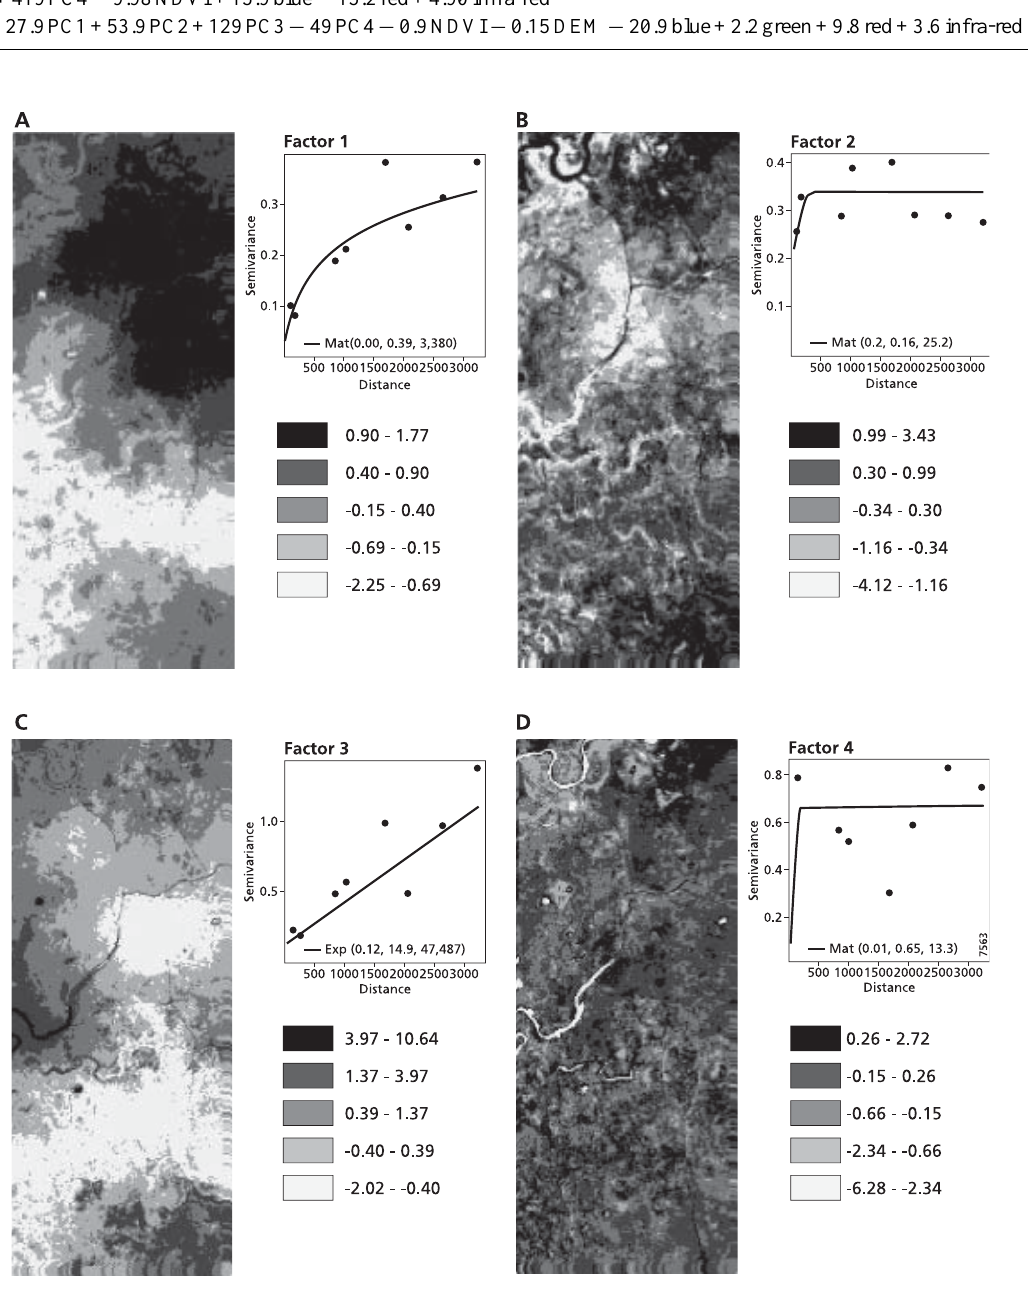
Fig. 5. Maps of the kriged estimates of factor scores and the semi-variograms of the residuals of the regression between factor axes and remotely sensed and ancillary data; fitted variogram models: mat: matheron family, exp: exponential. Values between brackets are nugget effect, structured variance and variogram range, respectively. (A) Factor 1; (B) Factor 2; (C) Factor 3; (D) Factor